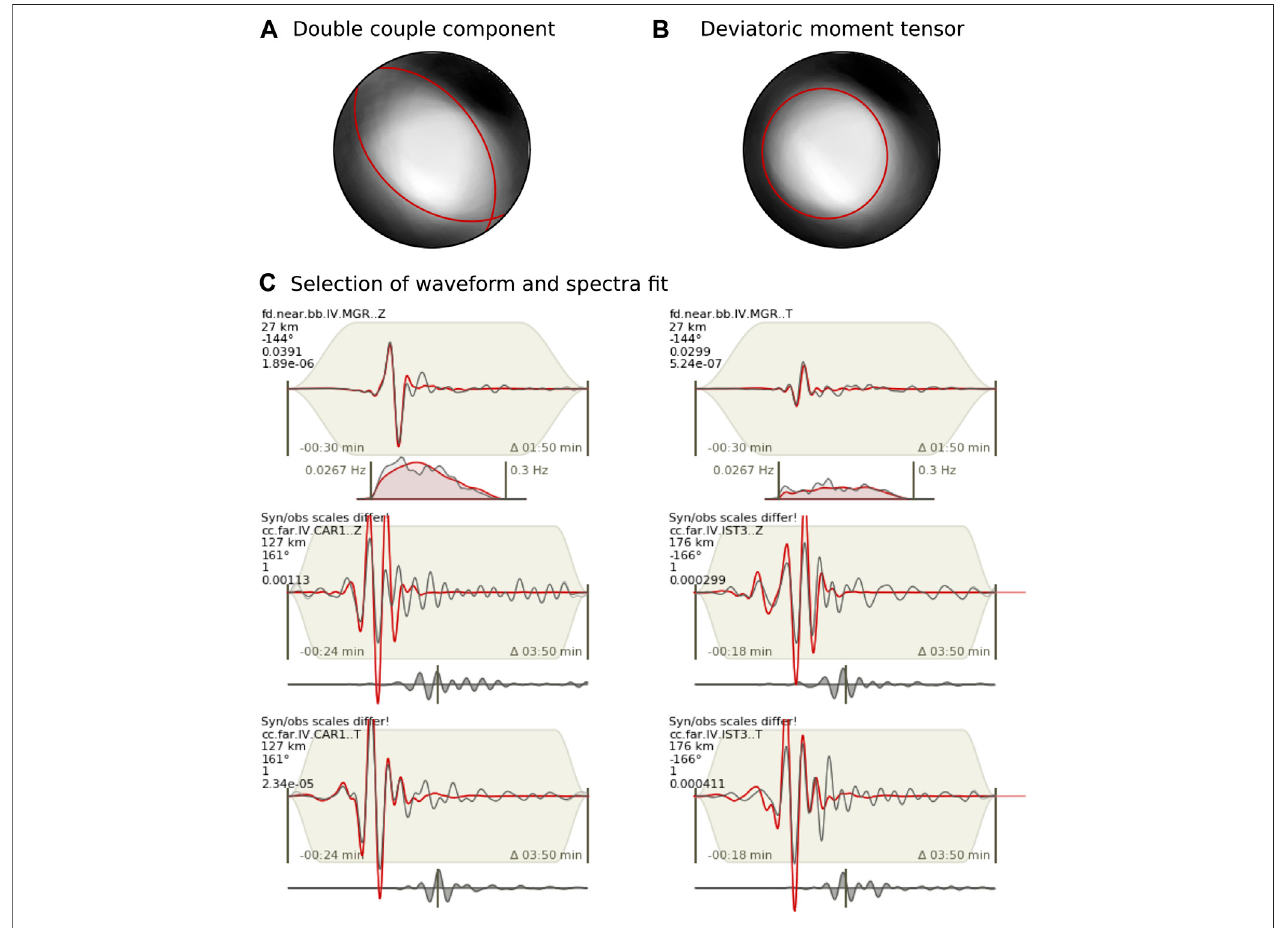
FIGURE 2 | Focal spheres for the moment tensor result, showing the overlay of the ensemble of pure double couple (A) and deviatoric moment tensors (B) out of theGrondbootstrapanalysis,whereareadlinedenotesthefocalsphereofthebestsolutions.Panel (C) showsaselectionofdata fi t(syntheticwaveformsandspectrain red, observations in black), illustrating different fi tting procedures and stations located at different distances and azimuths (the main information is reported in each subplot).